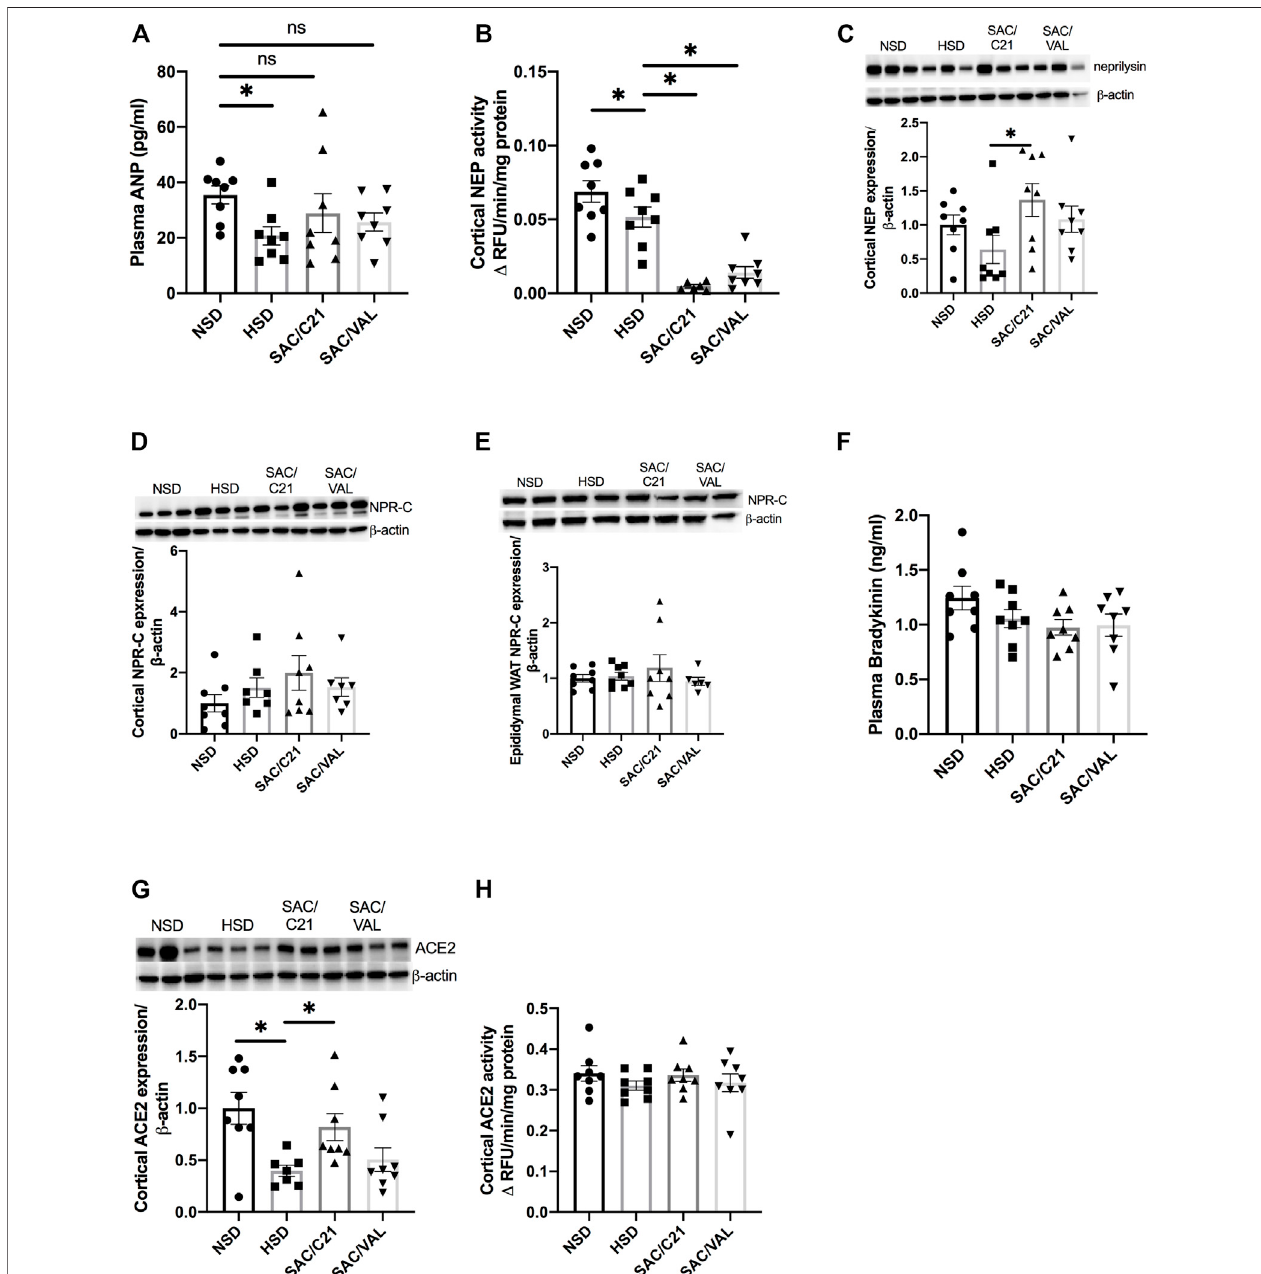
FIGURE 3 | (A) plasma ANP, (B) Neprilysin activity in kidney cortex, (C) Neprilysin expression in kidney cortex, (D) NPR-C expression in kidney cortex, (E) NPR-C expression in white adipose tissue, (F) plasma bradykinin, (G) ACE2 expression in kidney cortex, and (H) ACE2 activity in kidney cortex from obese Zucker rats on NSD or HSD and treated with vehicle, SAC/C21, or SAC/VAL. Data shown as mean ± SEM, analyzed by one-way ANOVA, followed by Fisher ’ s LSD test. Results are considered signi fi cant at * p < 0.05, with a 95% con fi dence interval; n (cid:1) 6 – 8 for neprilysin activity and renal NPR-C and ACE2 expression and n (cid:1) 8 for plasma ANP and bradykinin, expression of renal neprilysin and adipose NPR-C, and renal ACE2 activity. NSD — normal salt diet fed + vehicle treated obese control, HSD — high salt dietfed+vehicletreatedobesecontrol,SAC/C21 — highsaltdietfedobeserattreatedwithsacubitril+C21,SAC/VAL — highsaltdietfedobeserattreatedwithsacubitril +